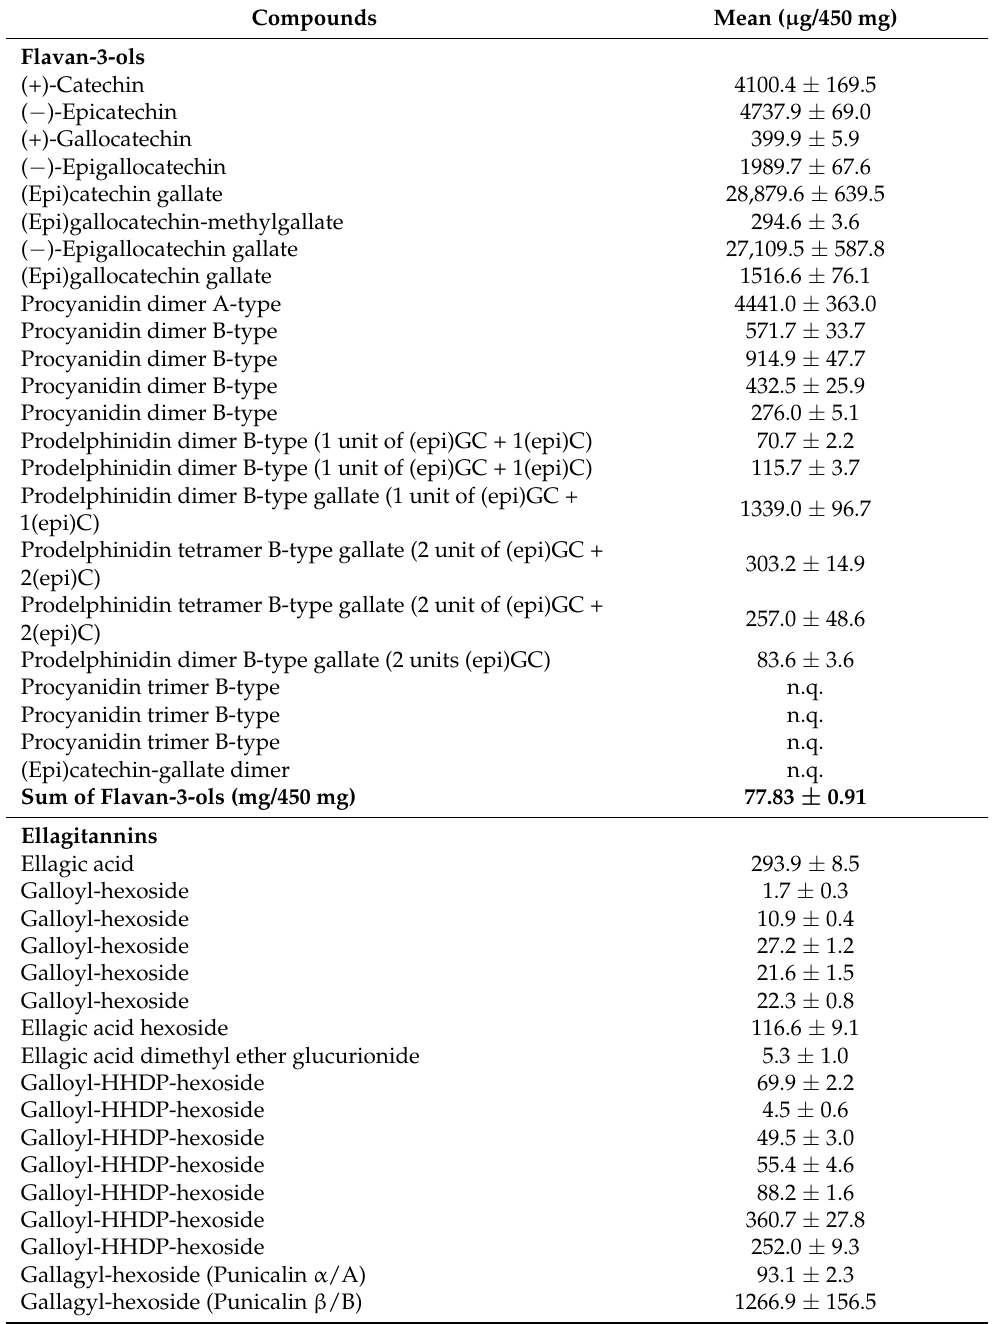
Table 3. Quantification of detected (poly)phenols occurring in the supplement. Values are expressed as mean ± SD ( n =